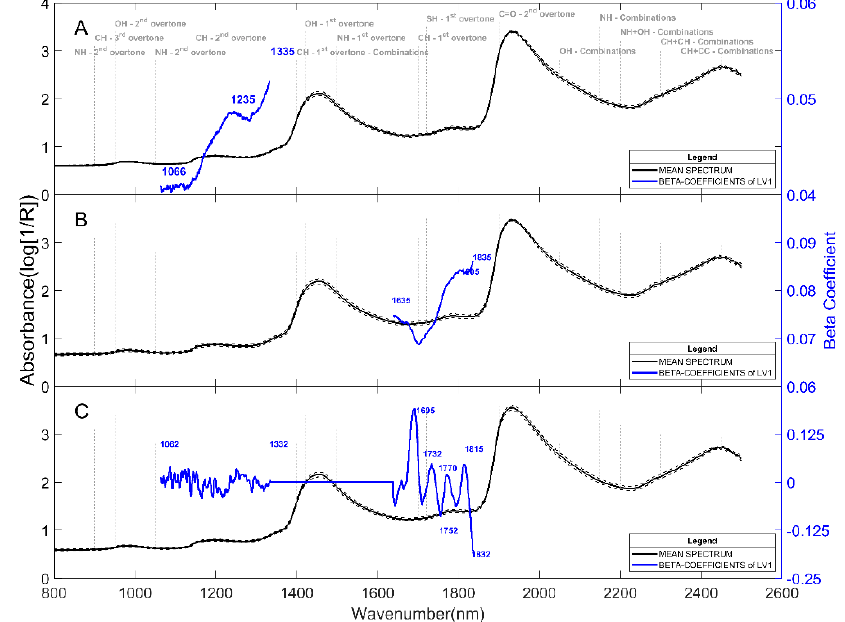
Figure 4. Mean spectra and beta-coefficients of the first PLS models latent variable to predict the reducing sugars of the three potato varieties: Innovator ( A ), Lady Claire ( B ), and Markies ( C